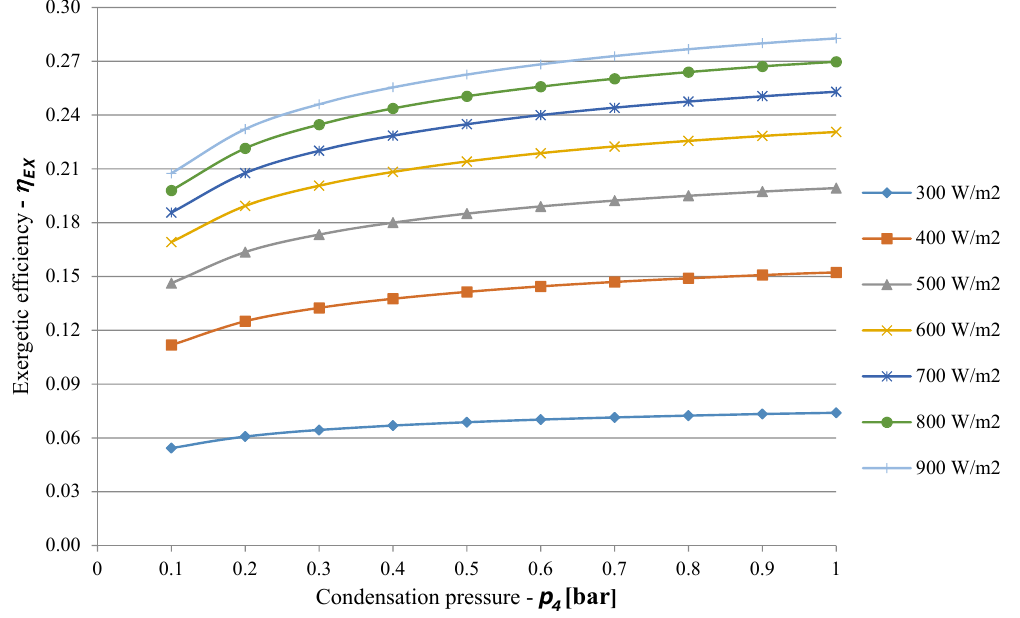
Figure 11. Exergetic efficiency versus condensation pressure under increasing solar radiations when the evaporation temperature is set at 300 °C. Energies 2020 , 13 , x FOR PEER REVIEW